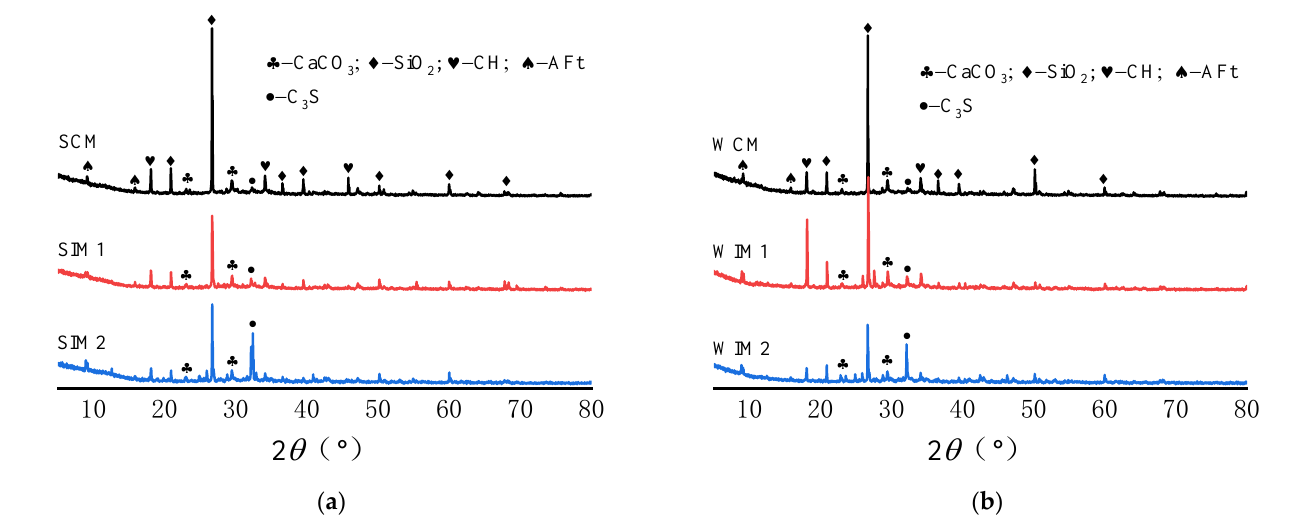
Figure 11. XRD patterns of different specimens: ( a ) 7 d; ( b ) 28 d. Table 5. Peak intensity of the main peak phase of each mortar sample.